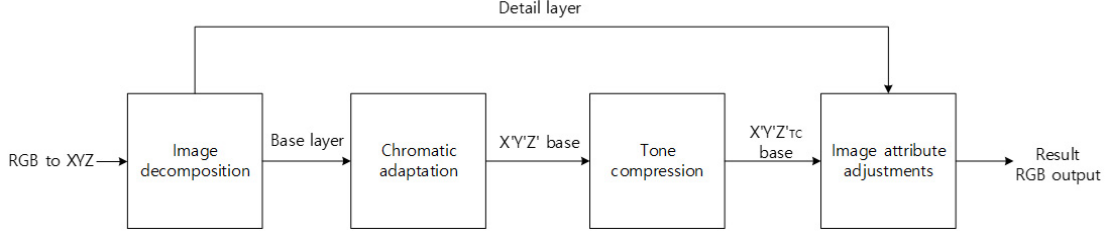
Figure 8. iCAM06 brief block diagram.